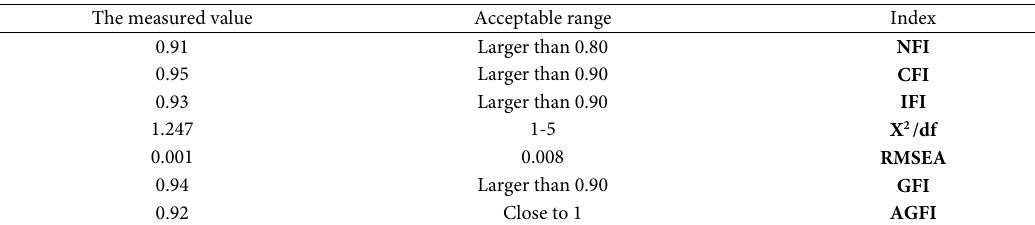
Table 2: Research model index of fit